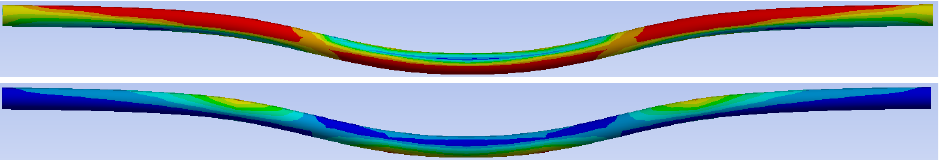
Figure 30. Experiment B: Detailed stress (MPa) ( above ), detailed plastic deformation (-) ( below ) (colour scale valid form the previous figure).